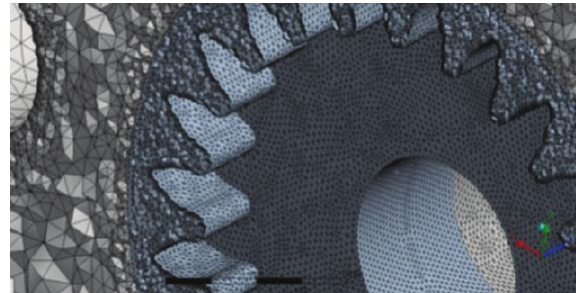
Figure 4: Partition of the mesh: the dynamic zone is marked with light blue, and the static zone is marked with light